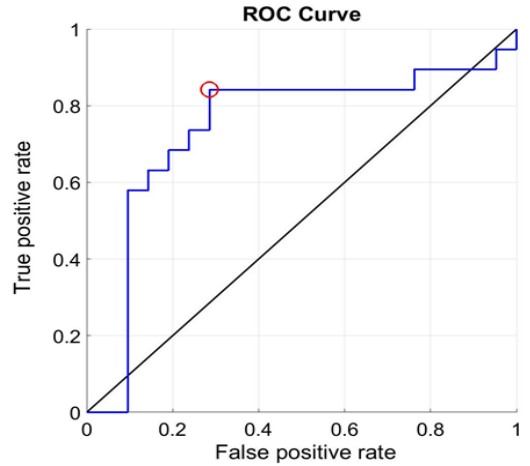
Figure 10. The receiver operating characteristic curve (ROC) for investigation B.